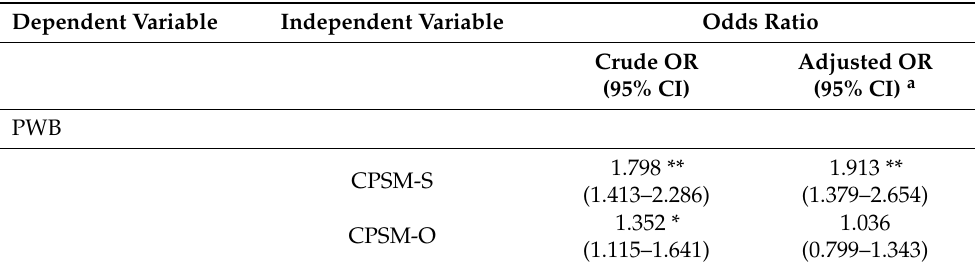
Table 3. Ordinal logistic regression analyses showing the relationship between cell phone social media use variables (CPSM-S and CPSM-O) and psychological well being (PWB) ( n = 523). Dependent Variable Independent Variable Odds Ratio